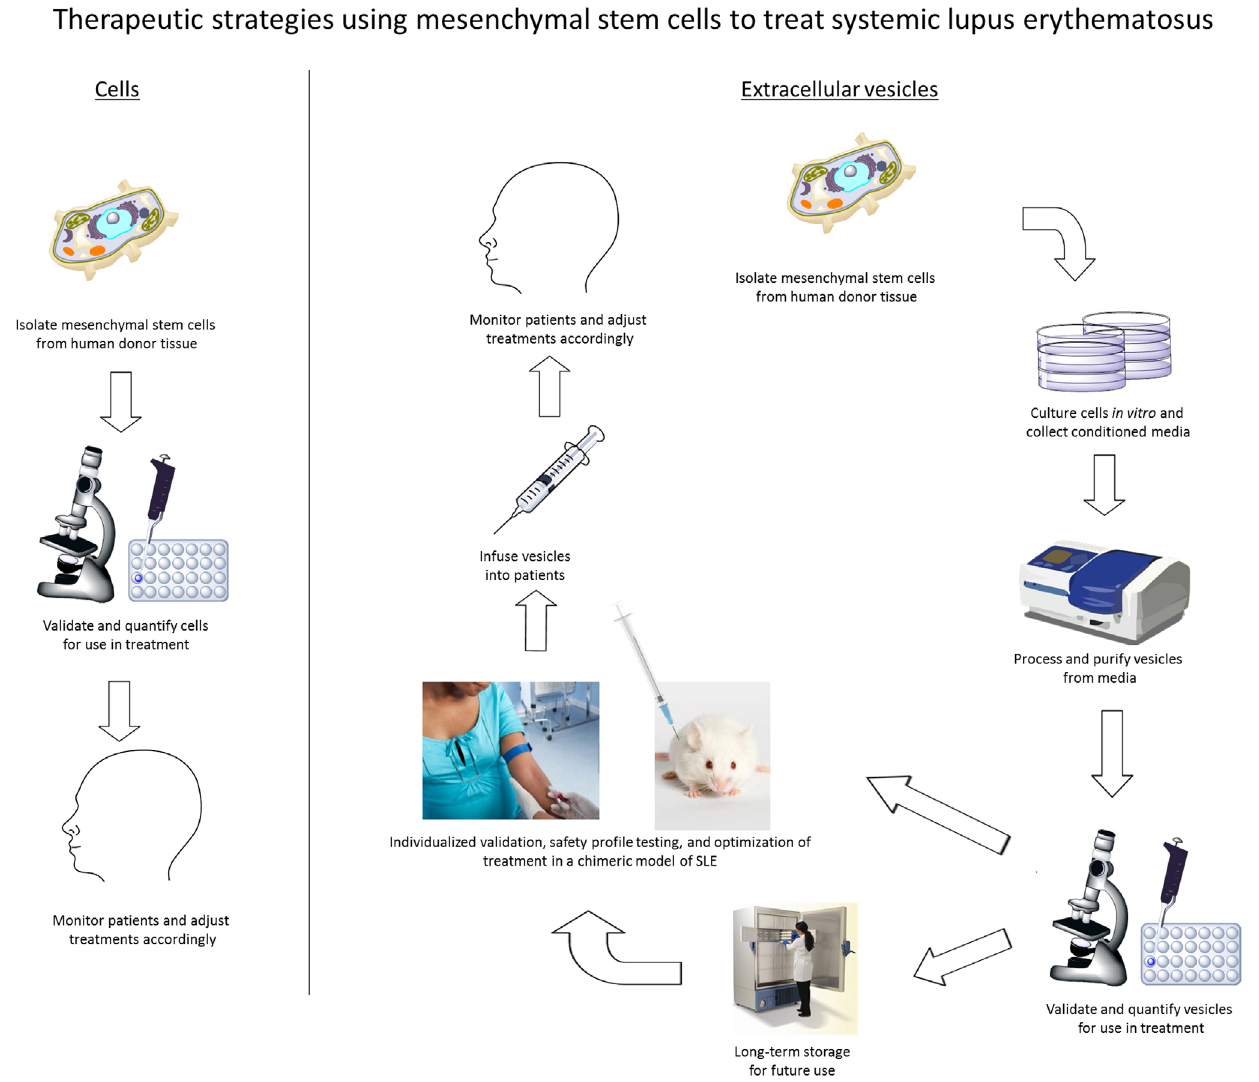
FiGURe 1 | Therapeutic strategies for the use of either mesenchymal stem cells (MSCs) or extracellular vesicles from MSCs to treat autoimmune diseases, including systemic lupus erythematosus